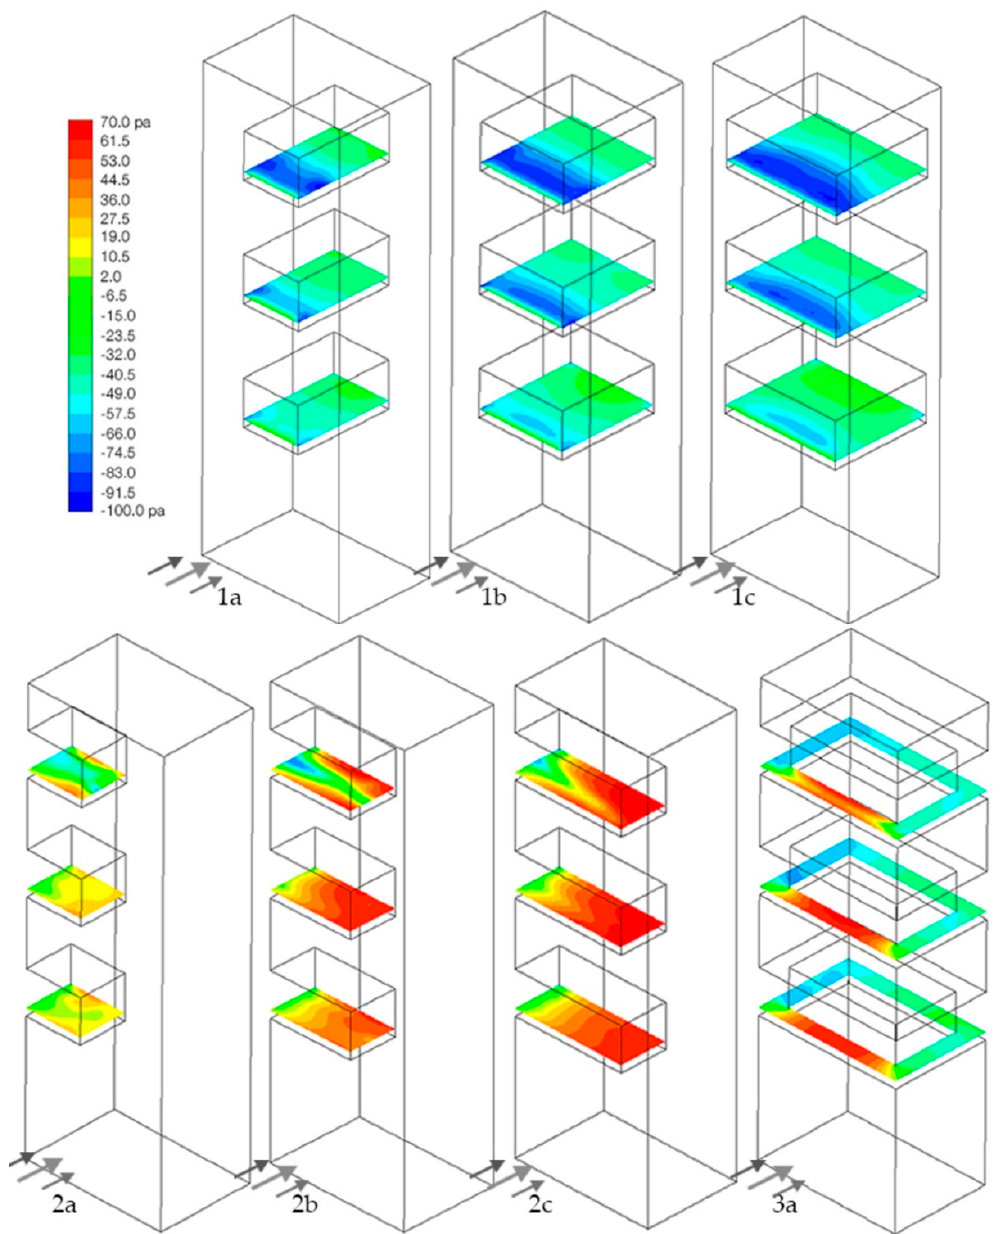
Figure 9. Pressure contours at different heights for different sky garden configurations; (1a) Central sky garden b/B = 0.4, (1b) Central sky garden b/B = 0.6, (1c) Central sky garden b/B = 0.8, (2a) Corner sky garden b/B = 0.4, (2b) Corner sky garden b/B = 0.6, (2c) Corner sky garden b/B = 0.8, (3a) Periphery sky garden a/A = 0.5